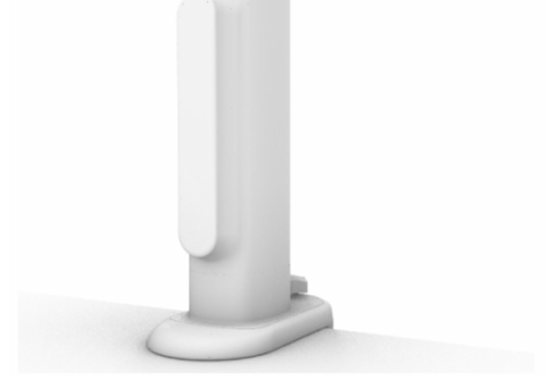
Figure 20. Control